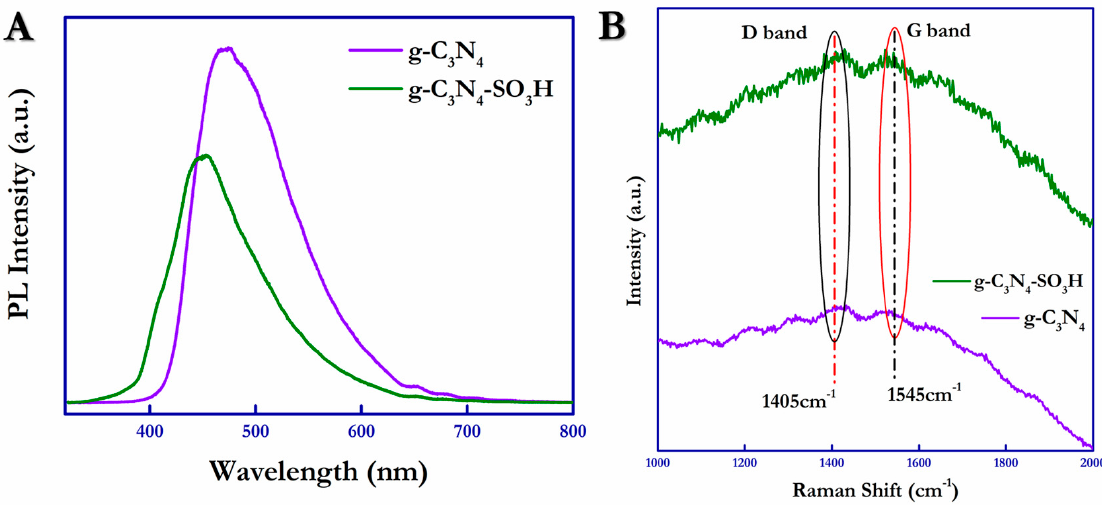
Figure 5. Photoluminescence spectra ( A ) and Raman spectra ( B ) of prepared g-C 3 N 4 and g-C 3 N 4 –SO 3 H.